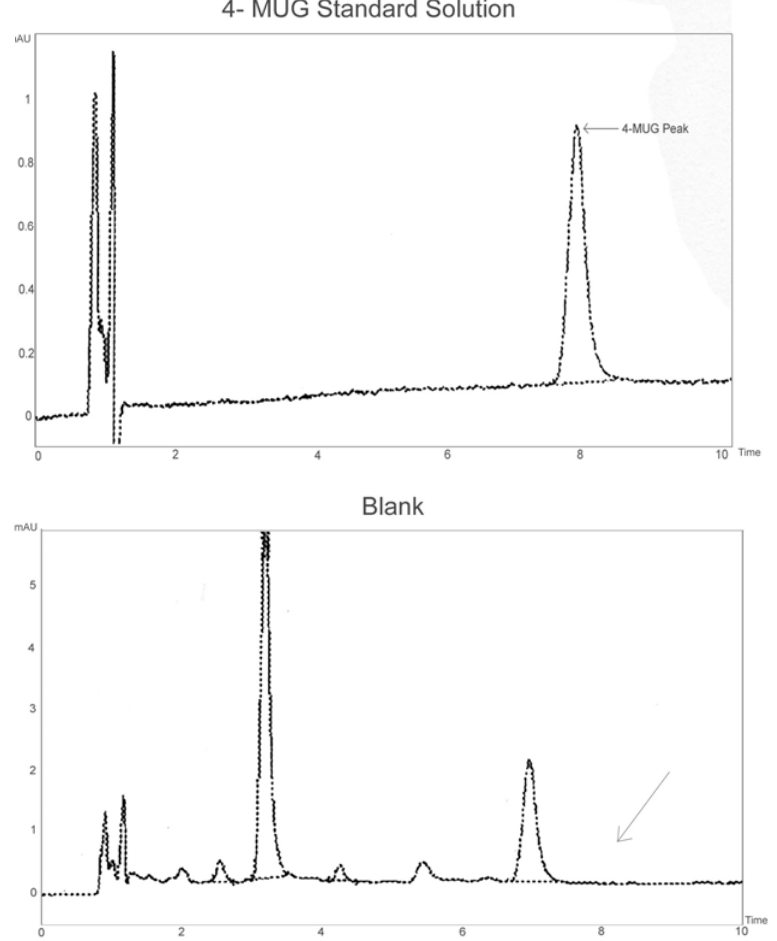
Figure 1. HPLC separation of 4-MU glucuronide (4-MUG) in a standard solution or in the cell lysate. In the blank (with Orthosiphon stamineus extract and UDPGA added